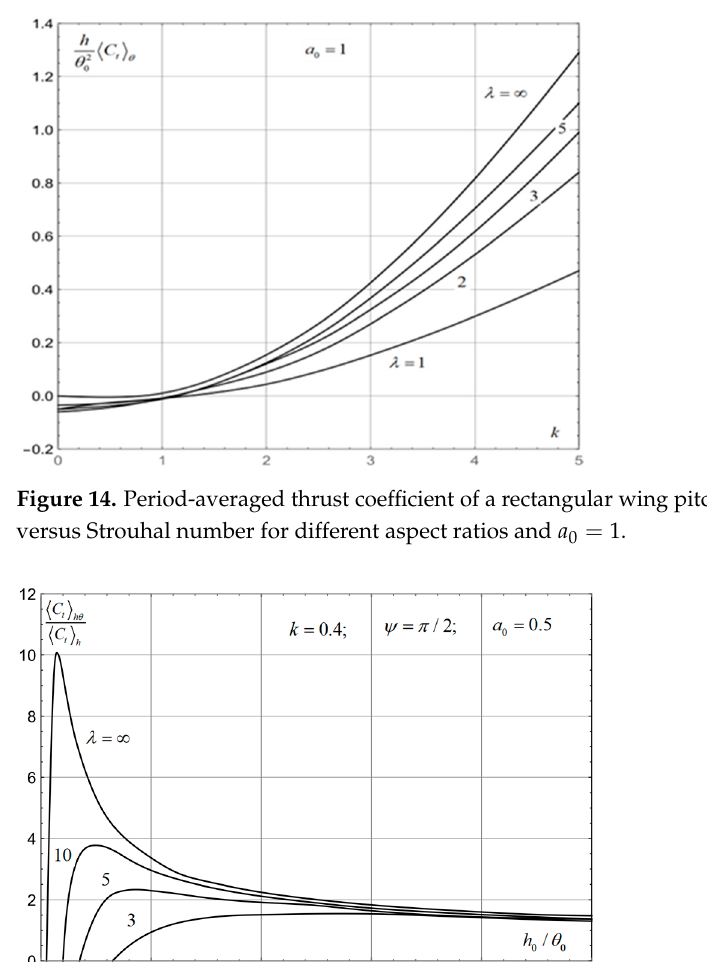
Figure 15. For combined heaving–pitching oscillations versus amplitude ratio and different λ